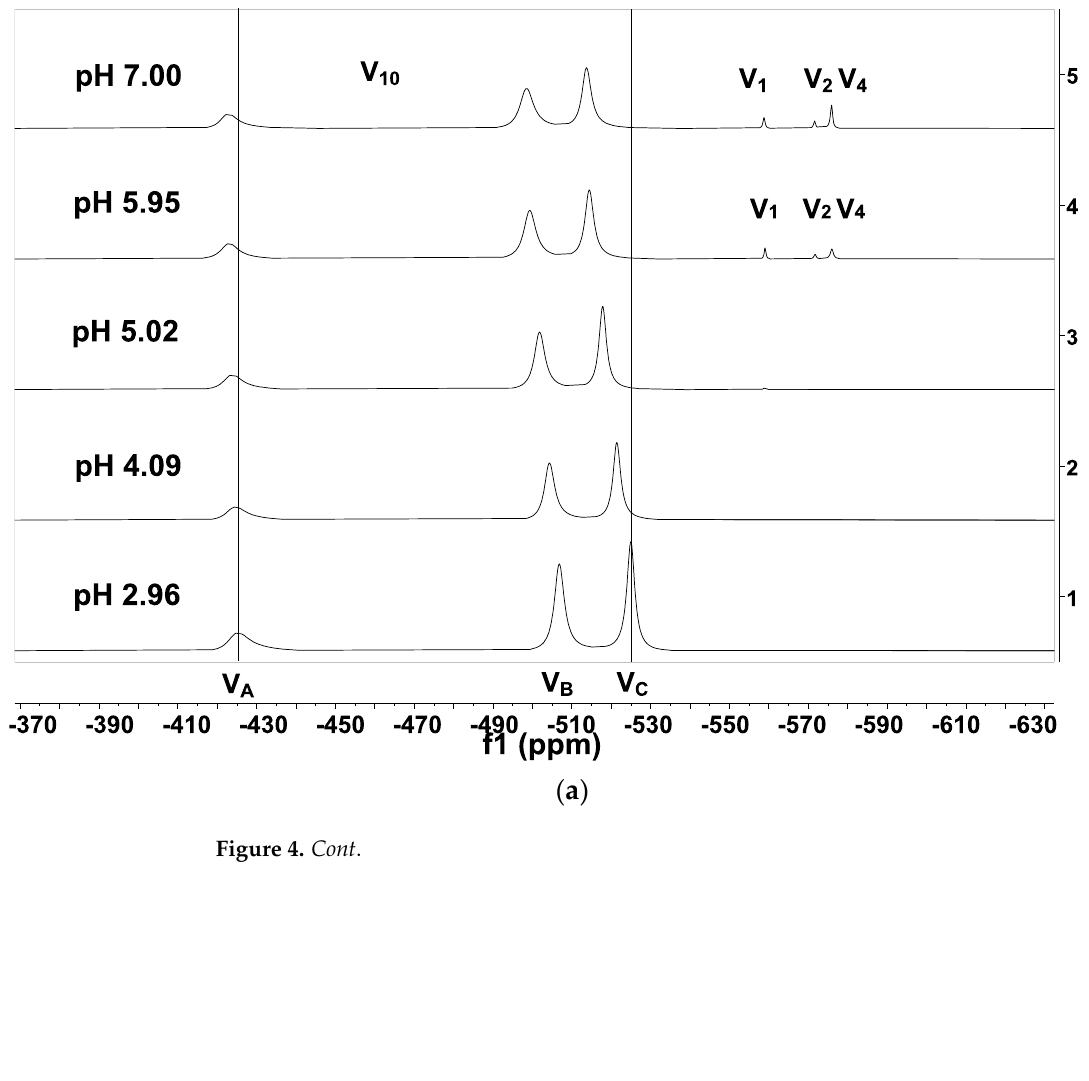
9 of 18 Figure 3. Distribution diagram in a solution of 50 mM NaVO 3 and 50 mM V atoms (5 mM V 10 ) in 0.15 M NaCl as a function of pH. The species are indicated by their formulas, including showing different protonation states. The figure is adapted with permission Ref. [90]. © 2012 by the American Chemical Society. NMR chemical shifts are known to vary with the protonation states and can be used for titration of the protonation/deprotonation of the V 10 and to determine the respective